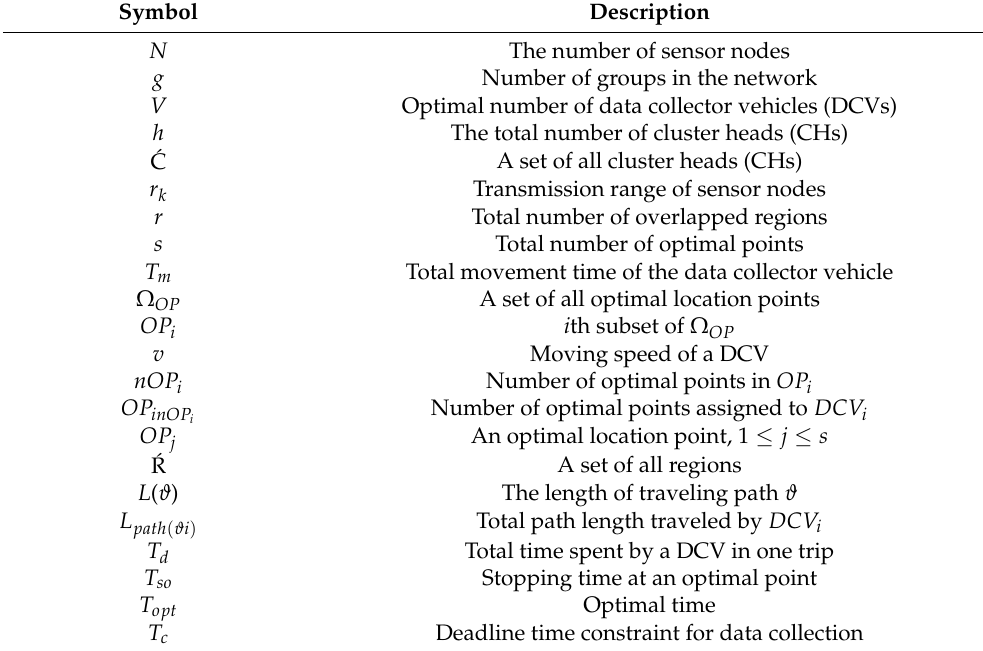
Table 3. Notations with their descriptions.